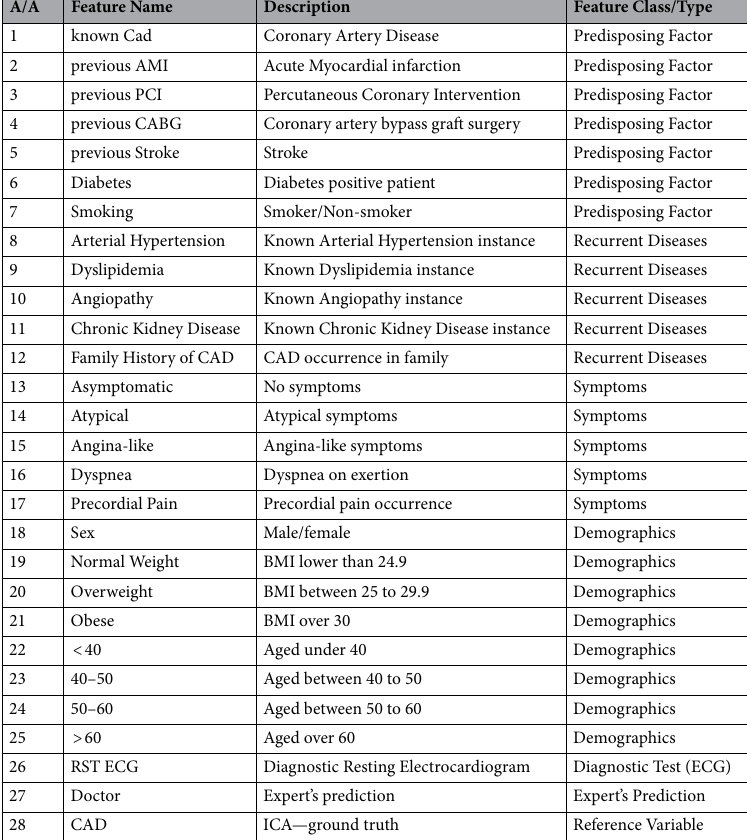
Table 2. Features used as input by prediction models, after binary